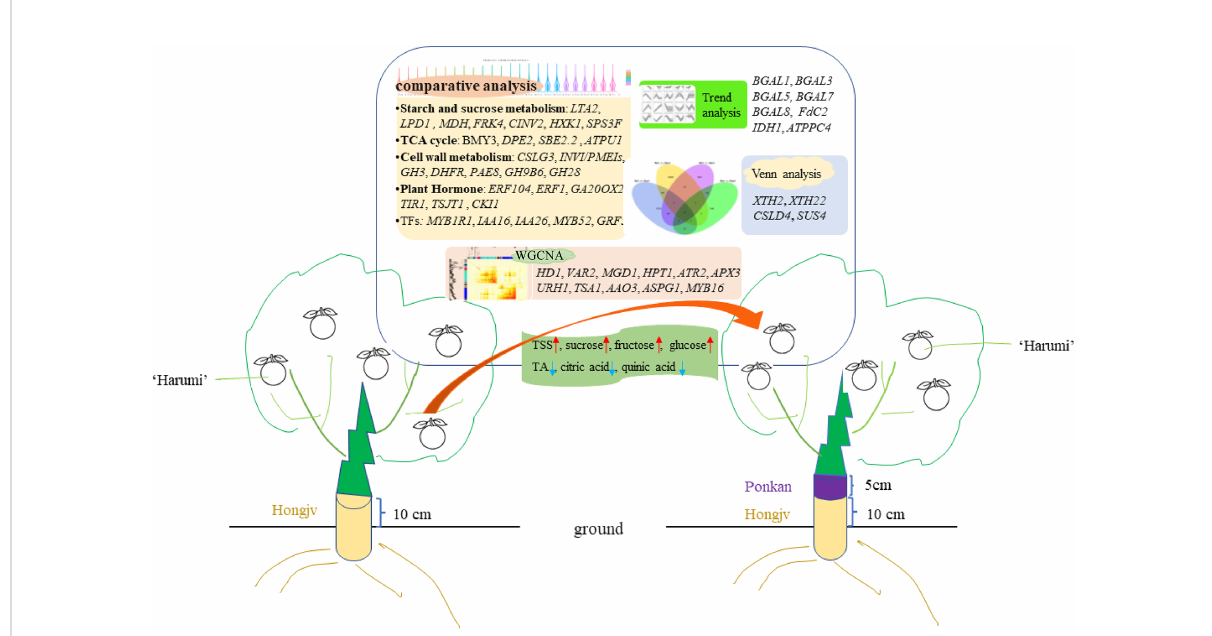
FIGURE 10 Proposed model for the interstock-mediated Harumi Tangor quality. A comparative analysis revealed that starch and sucrose metabolism, TCA cycle, cell wall metabolism, and Plant hormone are affected during fruit riping. Up arrows (red) represent raising, and down arrows (blue) represent lowering. Crucial genes based on the trend analyses, Venn analyses, and a WGCNA are